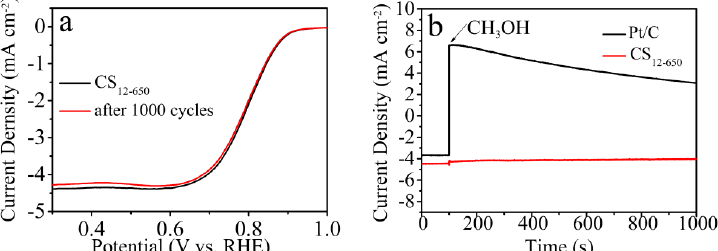
Figure 7. LSV curves of the CS 12-650 at 1600 rpm in O 2 -saturated 0.1 M KOH aqueous solution before and after 1000 cycles of CV curves with a scan rate of 50 mV/s ( a ). Current-time chronoamperometric responses of the commercial 20 wt% Pt/C and CS 12-650 at 0.75 V in O 2 -saturated 0.1 M KOH aqueous solution followed by addition of 3.0 M methanol. The rotation rate is 1600 rpm ( b ).